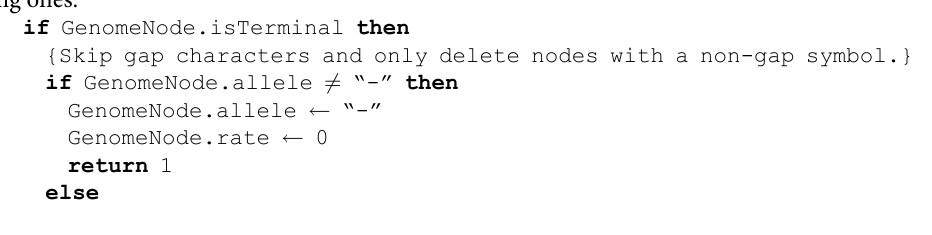
Algorithm 7 deleteNodes(Rand,GenomeNode,Layer,RemainingDeletions): recursive